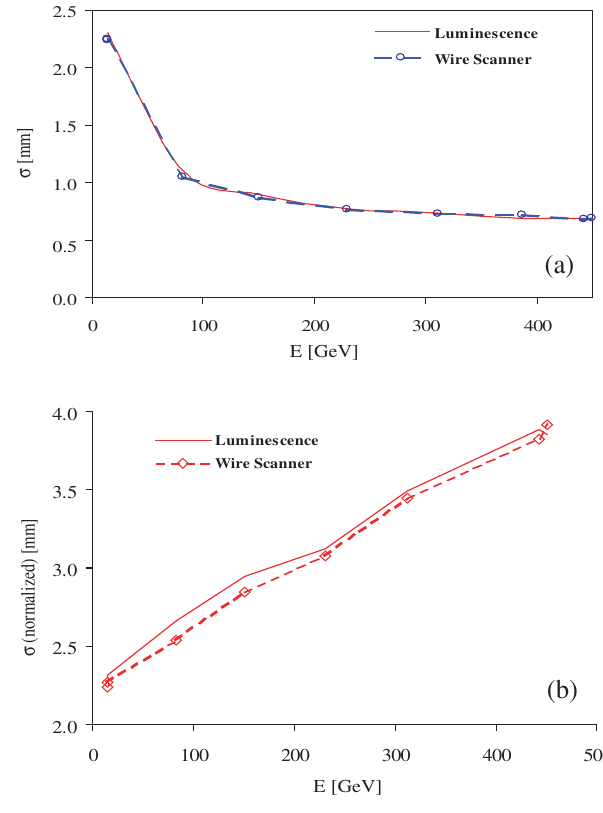
FIG. 8. (Color) (a) Beam size variation vs energy. The continu- ous and the dotted lines represent, respectively, the BPL and WS measurements. (b) Normalized beam size vs energy during the acceleration ramp. Note that the normalized beam size increases by roughly a factor of 2 which implies an estimated emittance blowup of a factor (cid:4) 4 . Figure 8(b) was already published in